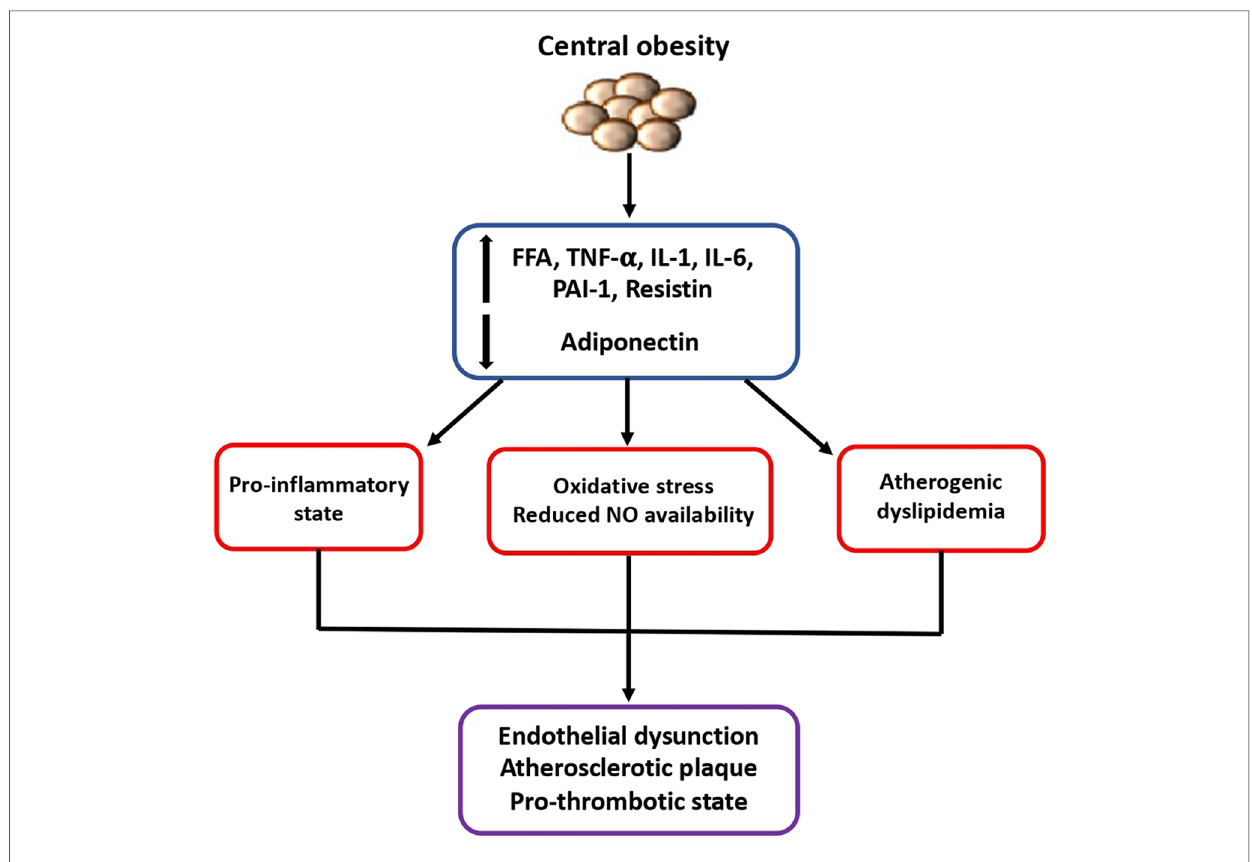
FIGURE 1 Mechanisms of higher susceptibility to cardiovascular diseases in obese patients. The expansion of visceral adipose tissue is associated to a dysregulated secretion of adipokines and other in fl ammatory cytokines which contribute to the development of insulin resistance, endothelial dysfunction, and prothrombotic state, fi nally leading to increased susceptibility to cardiovascular diseases. FFA, free fatty acid; IL-1, interleukin-1; IL-6, interleukin-6; NO, nitric oxide; PAI-1, plasminogen activator inhibitor-1; TNF, tumor necrosis